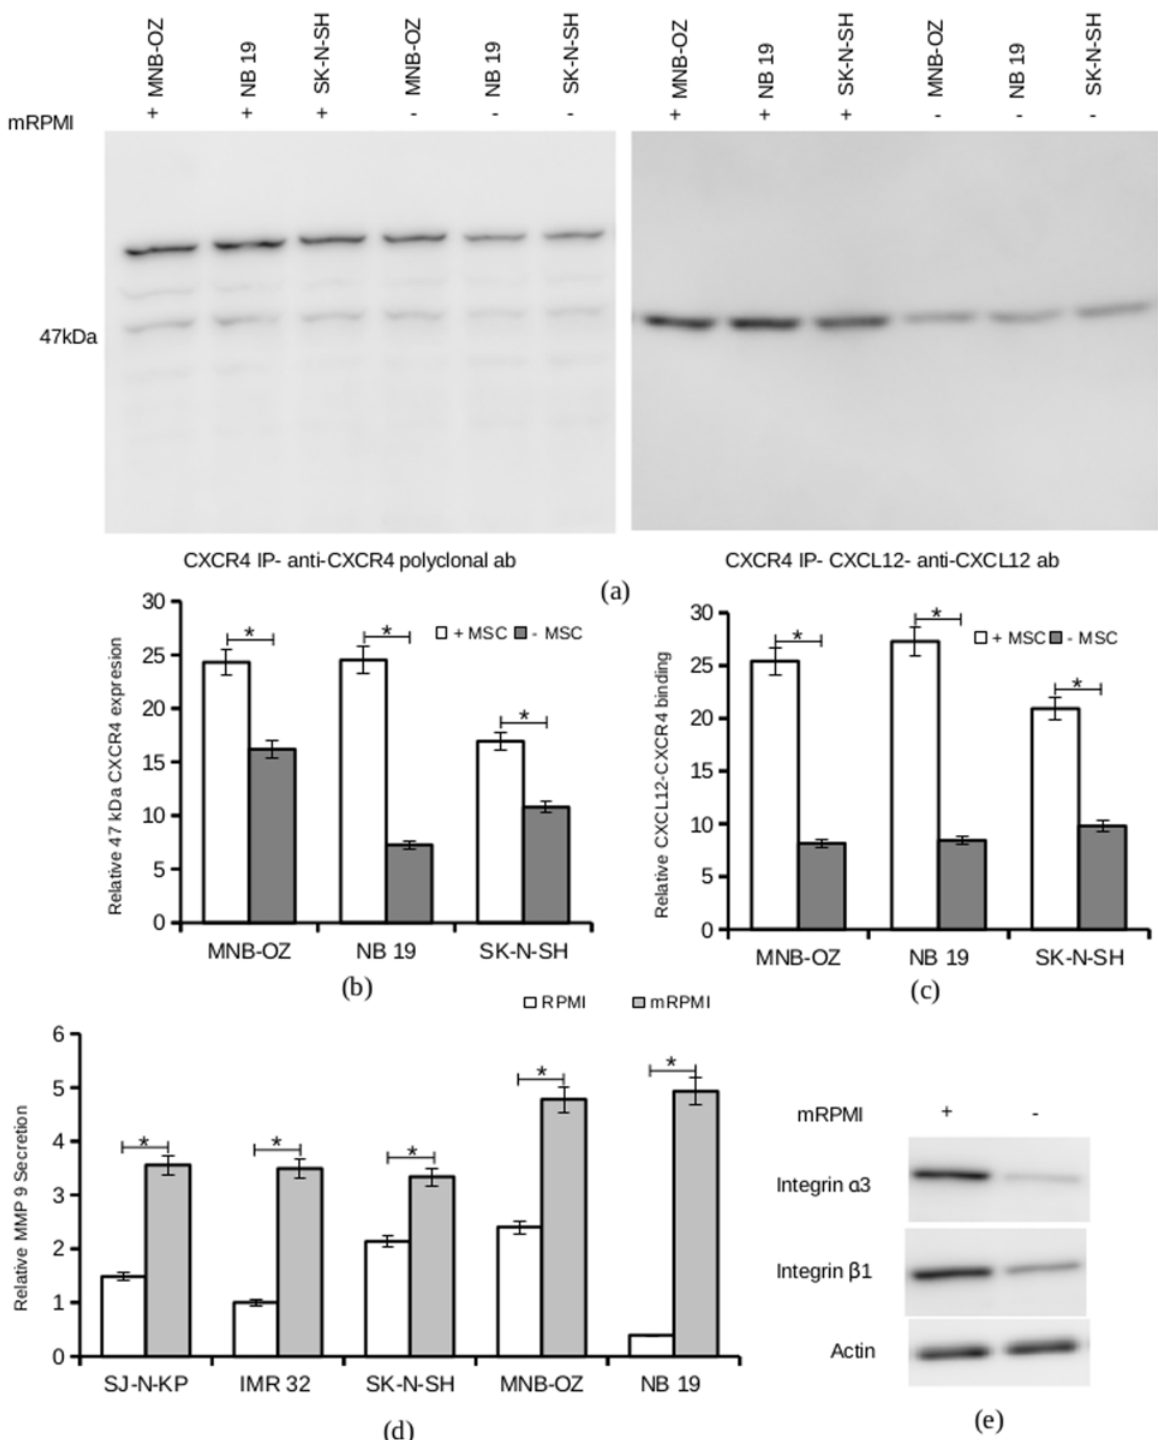
Fig 6. Effect of MSC secretome on neuroblastoma cell lines. a. (left panel) CXCR4 immune precipitates from cell lines MNB-OZ, NB 19 and SK-N-SH, serum-starved (control) and pre-treated with mRPMI were subjected to western blot analysis. Protein detection was carried out using anti-CXCR4 polyclonal antibody. Shown in figure is the representative result from 3 experiments. (right panel) CXCR4 immune precipitates from cell lines MNB-OZ, NB 19 and SK- N-SH, serum-starved (control) and pre-treated with mRPMI were electrophoresed and blotted on to PVDF membrane. The membrane was incubated with human CXCL12 overnight at 4°C. Protein detection was carried out using anti-CXCL12 antibody. Shown in figure is the representative result from 3